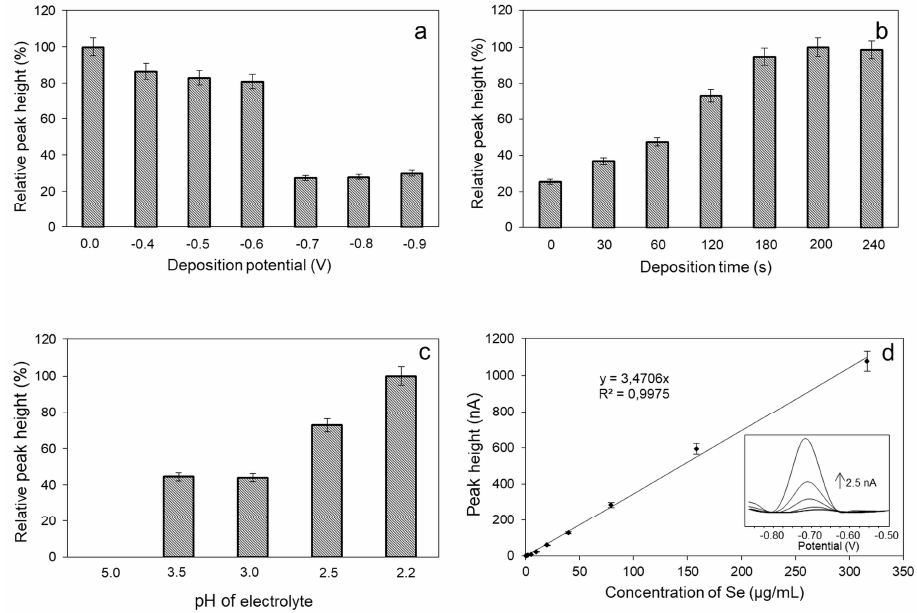
Figure 2. Optimization of the parameters of the method for Se(IV) determination: ( a ) The influence of deposition potential on the relative peak height of Se(IV); ( b ) the dependence of relative peak height on the deposition time; ( c ) the dependence of relative peak height on the supporting electrolyte pH (5.0, 3.5, 3.0, 2.5, and 2.2); and ( d ) calibration curve of Se(IV) for the concentration range 0.2–318 µ g/mL measured by DPCSV in 0.13 M ammonium sulphate, in the presence of 0.12 mM copper sulphate and sulfuric acid (pH adjusted to 2.2) playing the role of supporting electrolytes.